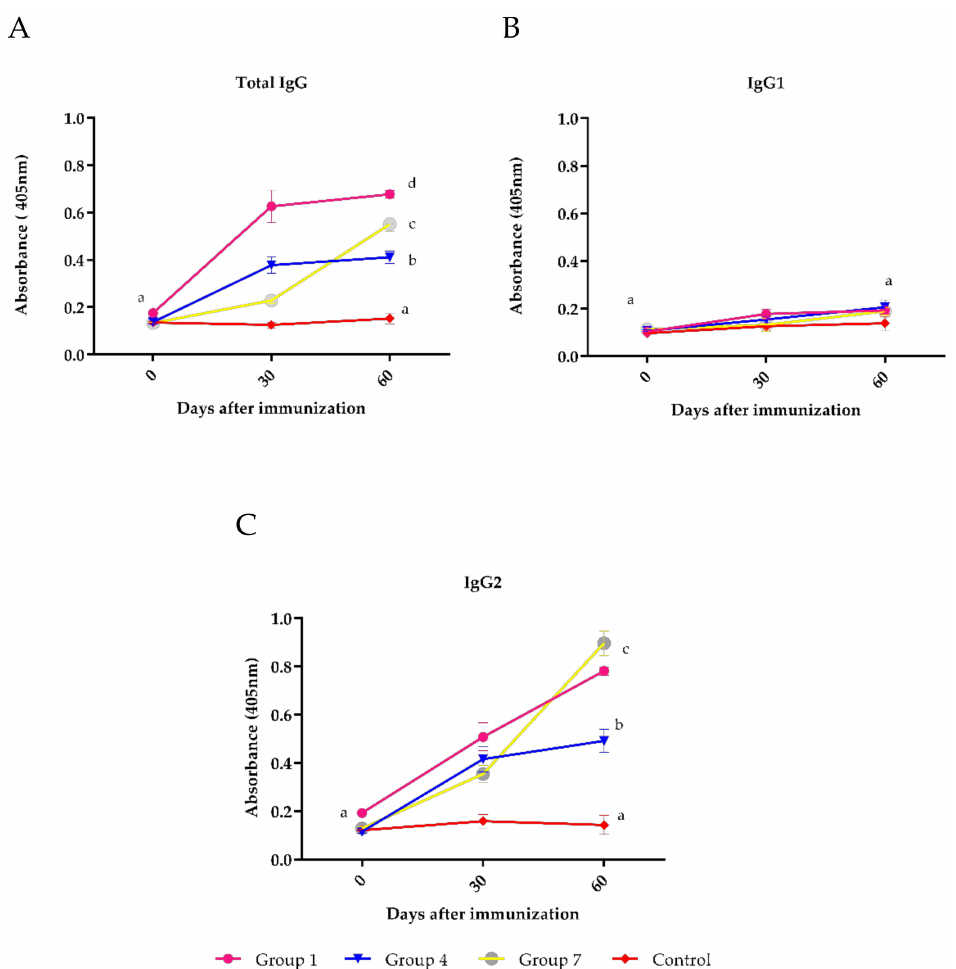
Figure 3. Antibody titers evaluated by ELISA in bovine sera immunized on day 0 with vaccine A and day 30 with vaccine D. Group 1 = vaccine A; group 4 = vaccine D; group 7 = vaccine A + D; and Control group = not vaccinated. Mean titers ± standard errors (SEM) are shown. Letters (a, b, c and d) highlight significant differences ( p < 0.05) between groups. A : Total IgG antibodies. B : IgG1 subclass antibodies. C : IgG2 subclass